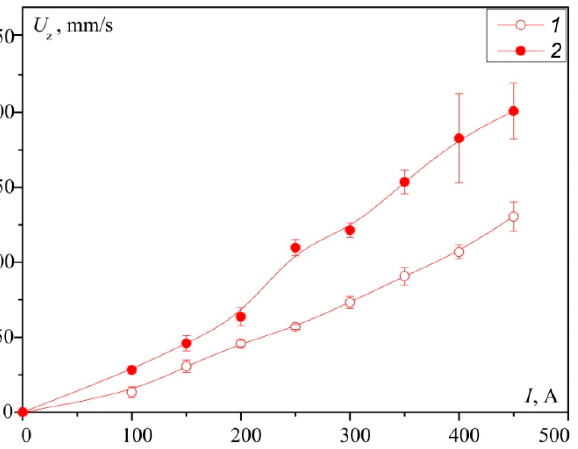
Figure 9. The dependence of the axial velocity on the electric current at depth z = 20 mm.